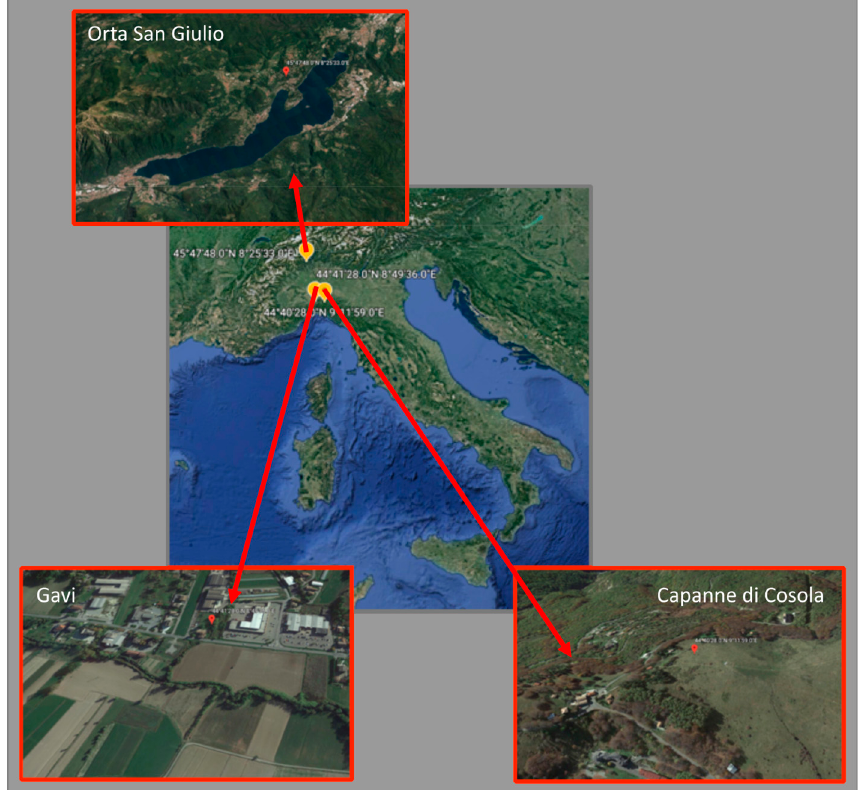
Figure 1. Areas where soil has been collected: a high mountain pasture (1500 a.s.l. located in Capanne